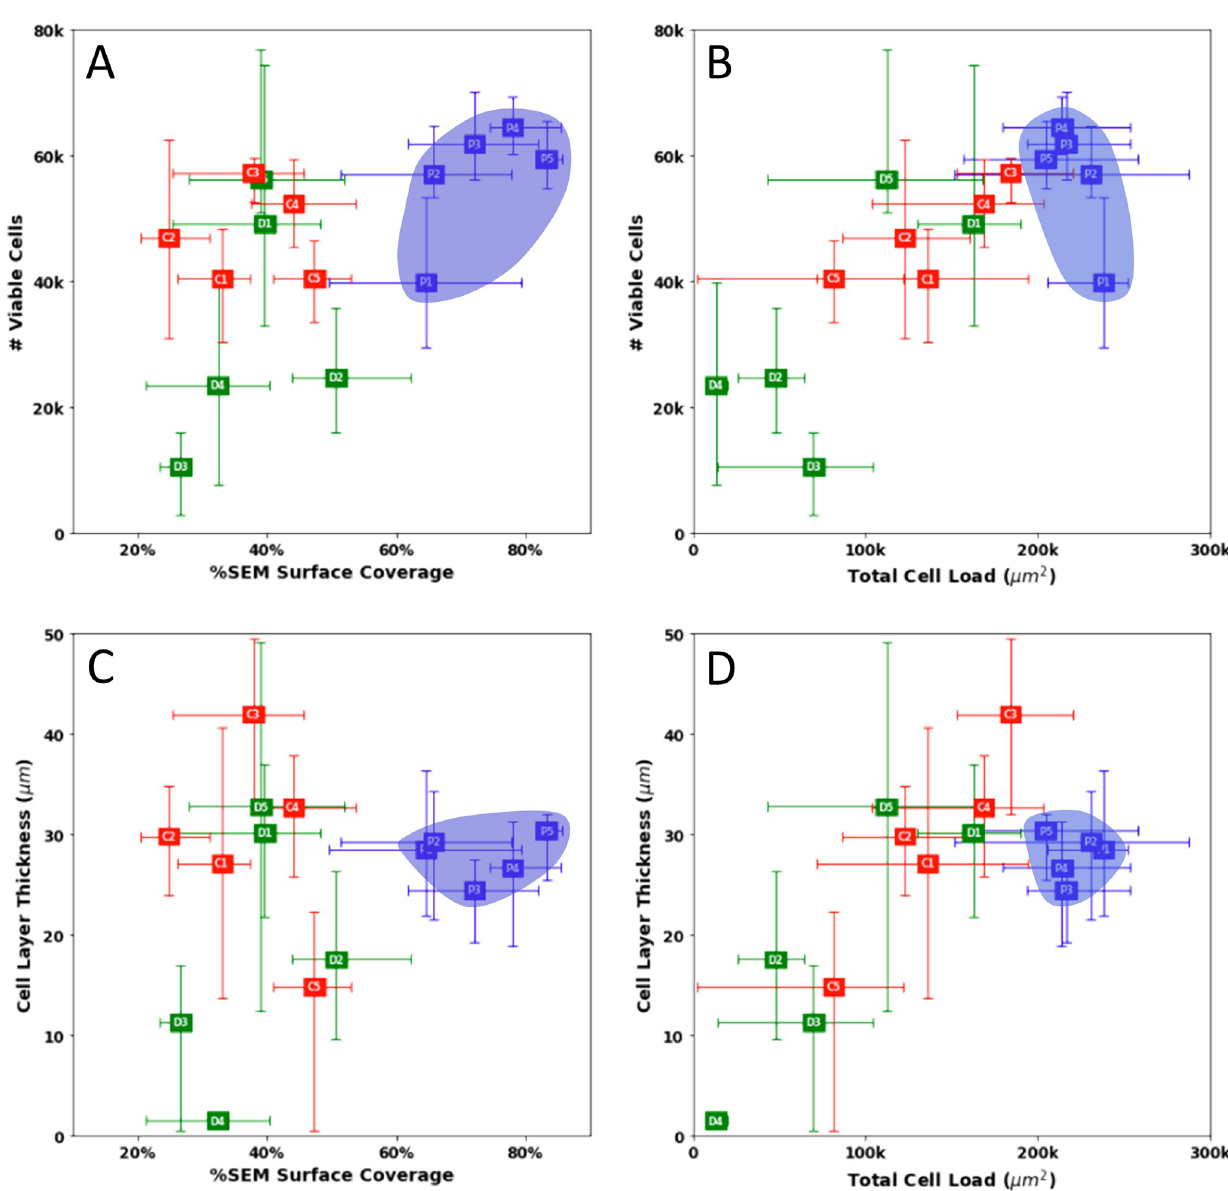
Fig 10. Scatter plots of combined data. The top left graph compares the average number of viable cells present on each scaffold section to the surface coverage determined with SEM analysis. The top right graph compares the number of viable cells and the cell load area as determined by H&E analysis. The bottom left graph compares the average cell layer thickness to SEM surface coverage and the bottom right graph compares cell layer thickness to cell load. Bioreactor mediated perfusion data is highlighted in